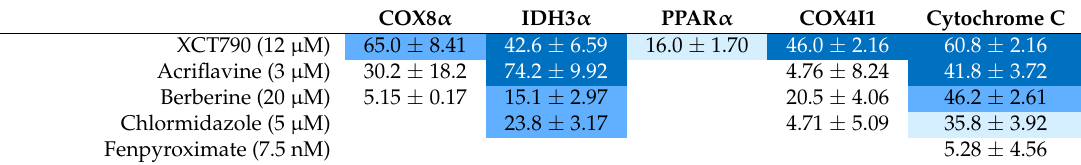
Table 4. Percent inhibition of mRNA gene expression of pesticide